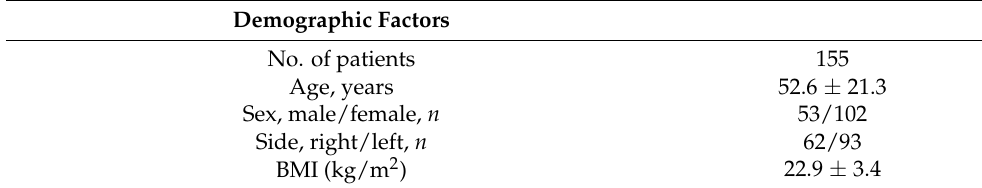
Table 1. Initial patient demographic and surgical factors.